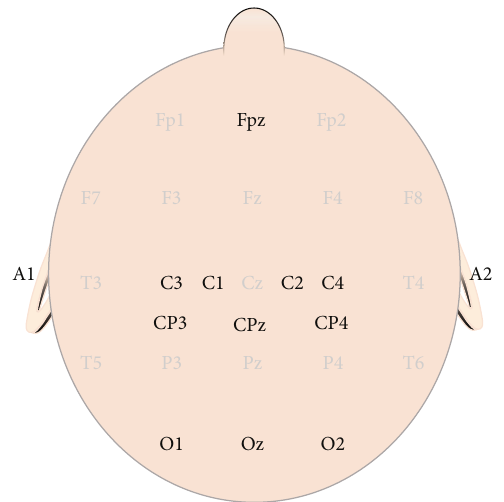
Figure 2: Electrode positions used for stimulating tceMEP, and recording SSEP, BAEP, and VEP. All recording locations are based on the International 10–20 System for Electrode Placement [28]. F: frontal; C: central; CP: midway between central and parietal;